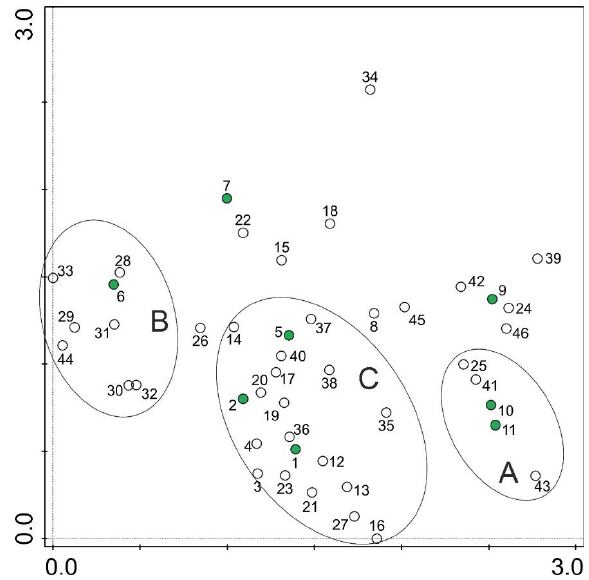
Figure 3. Results of the differentiation of diatom assemblages based on Detrented Correspondence Analysis (1–46—sampling stations, A – C —groups of diatom assemblages: A—spring section of the Sakarya River and small tributaries, B—assemblages from the area around Ankara and Polatlı, C—lower section of the Sakarya River and tributaries, green dots correspond to stations located on the Sakarya River).